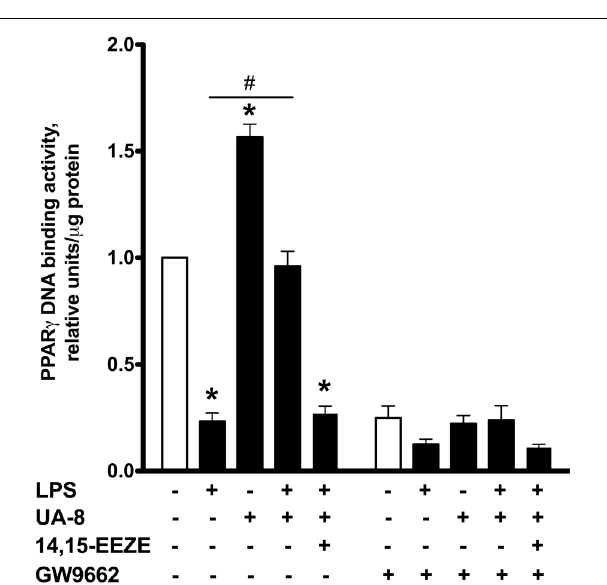
FIGURE 4 | Effect of UA-8 and LPS treatments on PPAR γ DNA binding activity in NCMS and its pharmacological inhibition with GW 9662. NCMs were treated with LPS (1 μ g/ml) and/or UA-8 (1 μ m) in the presence or absence of 14,15-EEZE (10 μ m) for 24 h. GW 9662 (1 μ m), a pharmacological inhibitor of PPAR γ , was added when indicated.Values are represented as mean ± SEM, N = 3–4. Significance was set at P < 0.05. * Significantly different from control. # Significantly different from LPS-treated